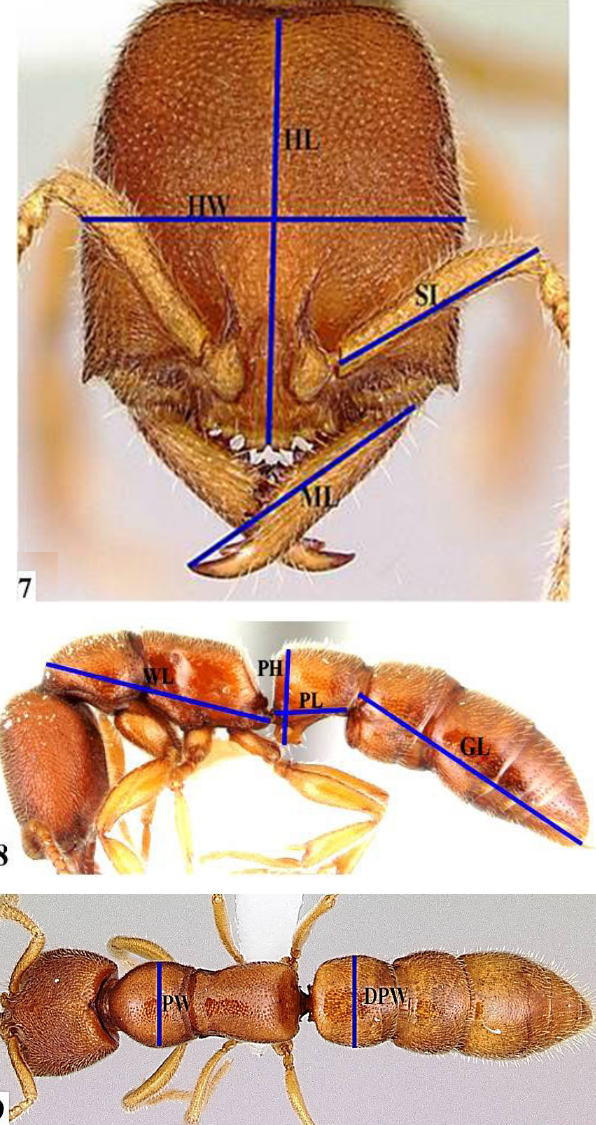
Fig 10-13. Stigmatomma sakaii (worker-image from antwiki): 10 . Head in full face-veiw; 11. Body in profile veiw; 12. Body in dorsal veiw; 13.